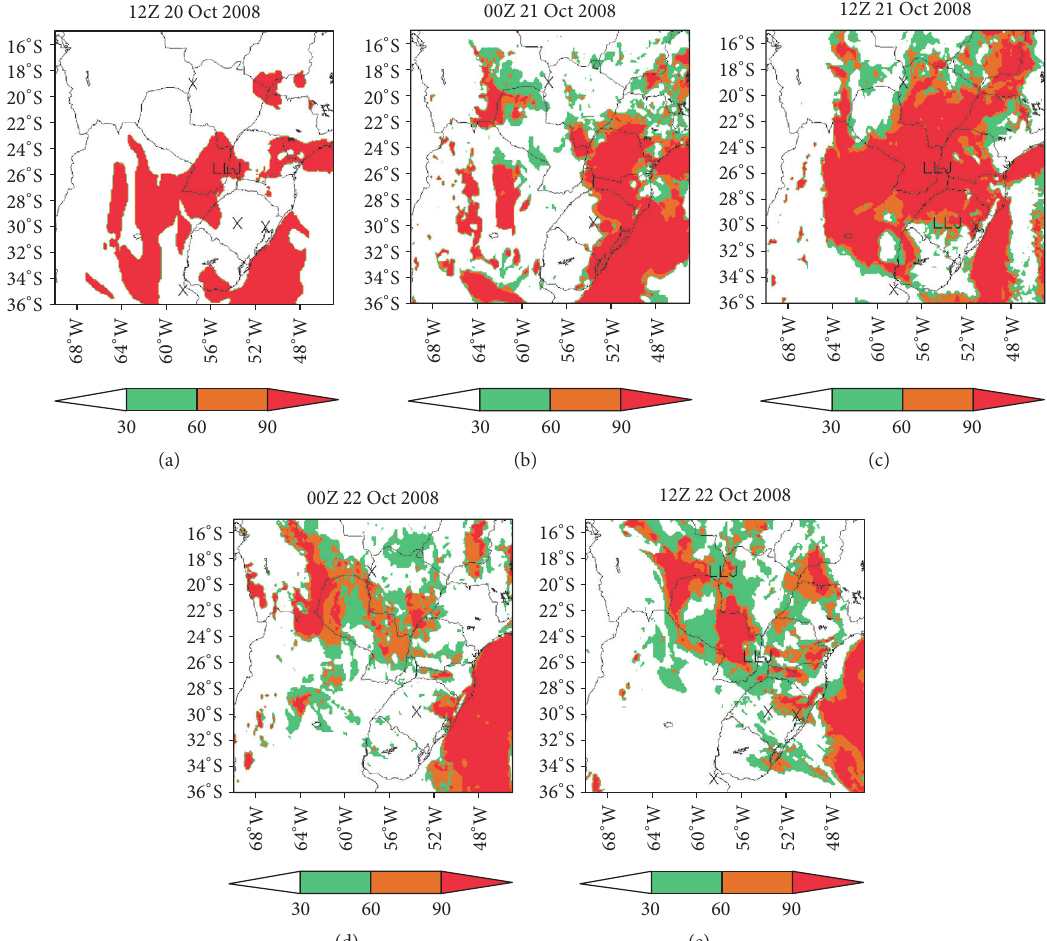
Figure 17: As in Figure 16 but for the simulations employing the YSU PBL parameterization scheme.